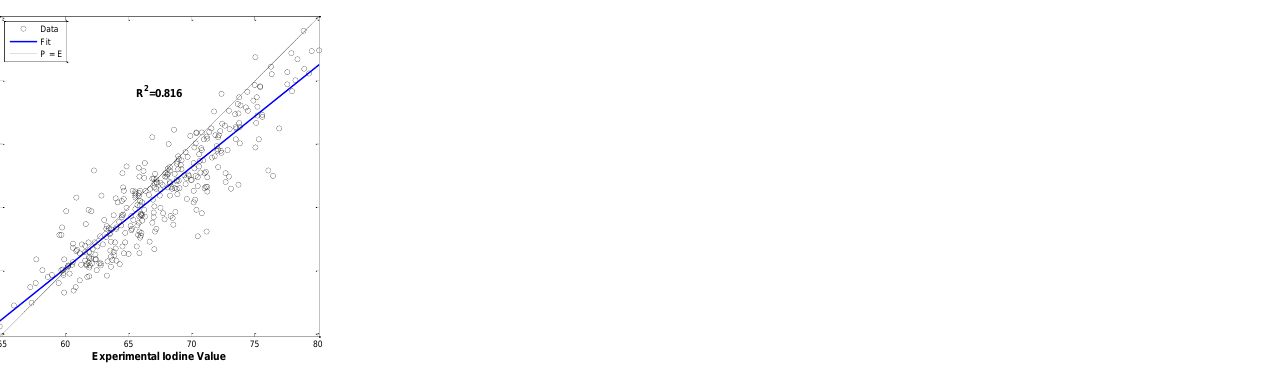
Fig. 7 Predicting Iodine value of fresh fat from predictive model built with Raman spectral data acquired from frozen fat